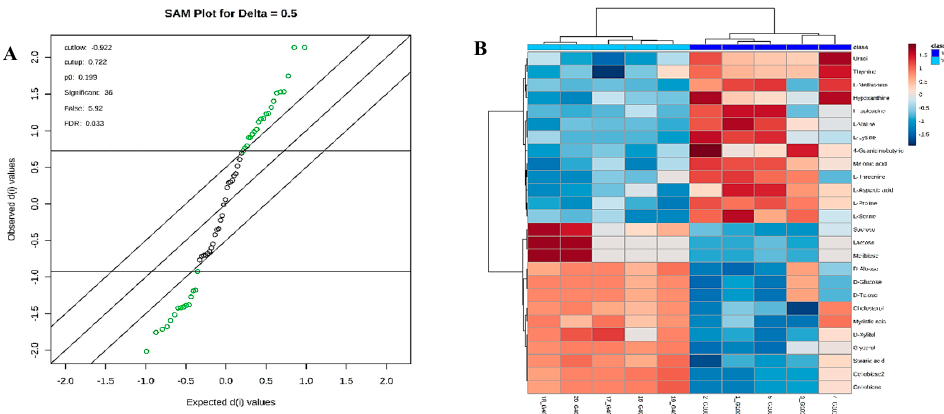
Figure 5. Significance analysis of microarray (SAM) plot ( A ) in positive mode (Delta score = 0.5, metabolites highlighted in green are significant). Significant changes in metabolites are expressed as a